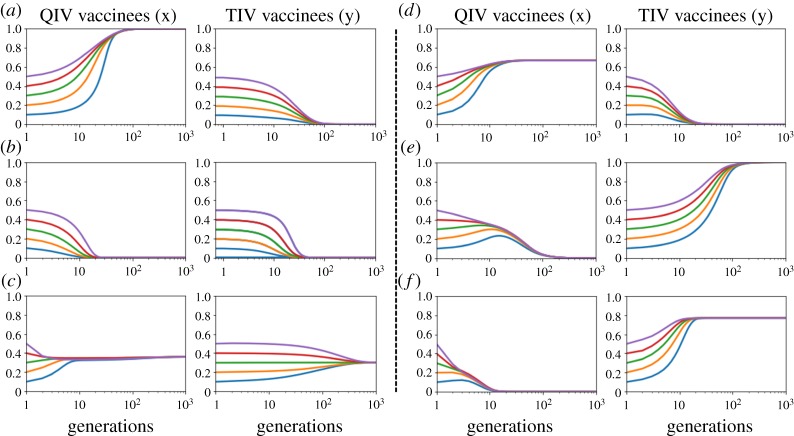
Six possible combinations of QIV and TIV vaccination coverages at equilibrium attained from the evolutionary equations (2.8) and (2.9). The evolutionary dynamics of the vaccination coverage depends upon the choice of different parameters. Clearly, there is no bi-stability at equilibrium. There are six possible mixtures of dynamics: (a) x = 1, y = 0, when CQ = CT = 0.4; eQ = 0.4, eT = 0.3. (b) x = 0, y = 0, when CQ = 0.6, CT = 0.4; eQ = 0.4, eT = 0.3. (c) x = x*, y = y*, (coexistence or internal equilibria) when CQ = 0.6, CT = 0.4; eQ = 0.8, eT = 0.4. (d) x = x* (internal equilibrium), y = 0, when CQ = CT = 0.4; eQ = 0.7, eT = 0.4. (e) x = 0, y = 1, when CQ = 0.6, CT = 0.4; eQ = 0.6, eT = 0.4. (f) x = 0, y = y*, when CQ = 0.6, CT = 0.4; eQ = 0.8, eT = 0.6. All cases presume, βA = βB = 0.5; γA = γB = 0.2. The initial value of y is kept as, 0.33, while we vary the initial values of x and vice versa. (Online version in colour.)